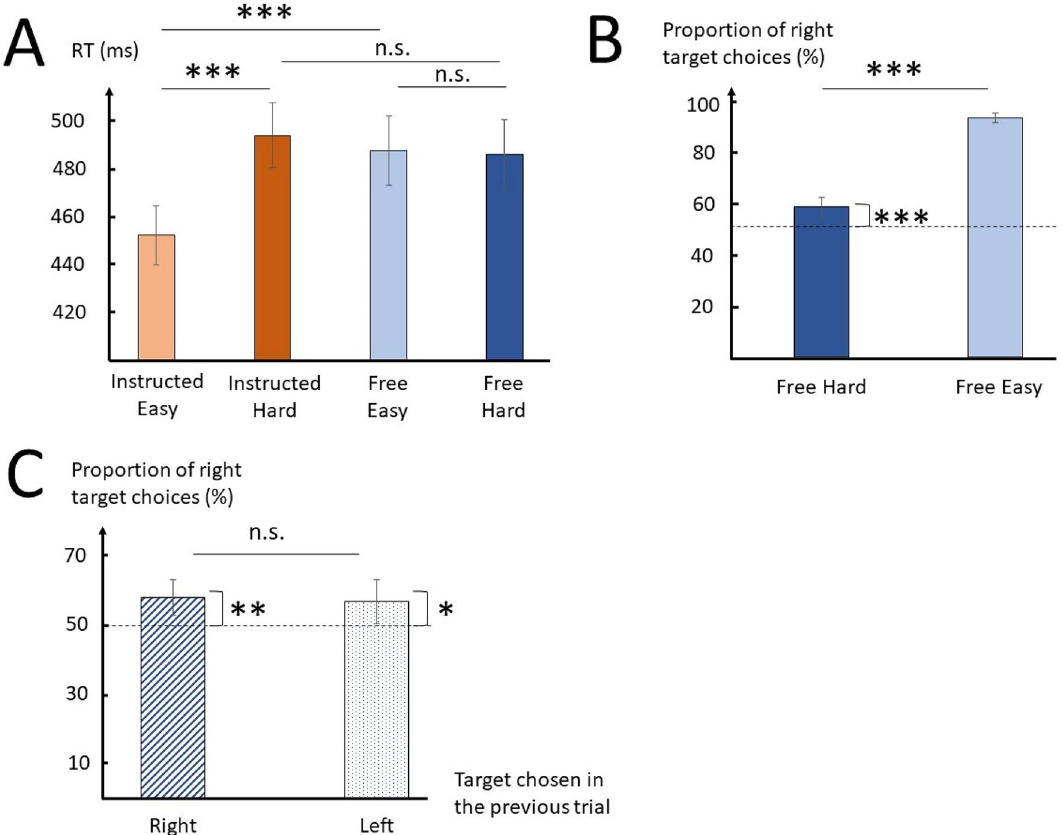
Figure 2. Effects of context and difficulty on RTs and target choices. ( A ) Average RT per condition. ( B ) Proportion of right target choices in Free, according to Difficulty. The dotted line indicates 50% of right target choices or PSE (right target chosen equally often than left). ( C ) Proportion of right target choices in Free Hard trials according to the target chosen in the immediately preceding trial (hatched bar = right target chosen, dotted bar = left target chosen). n.s. = non-significant p-value (p > 0.05), *p < 0.05, **p < 0.01, ***p <